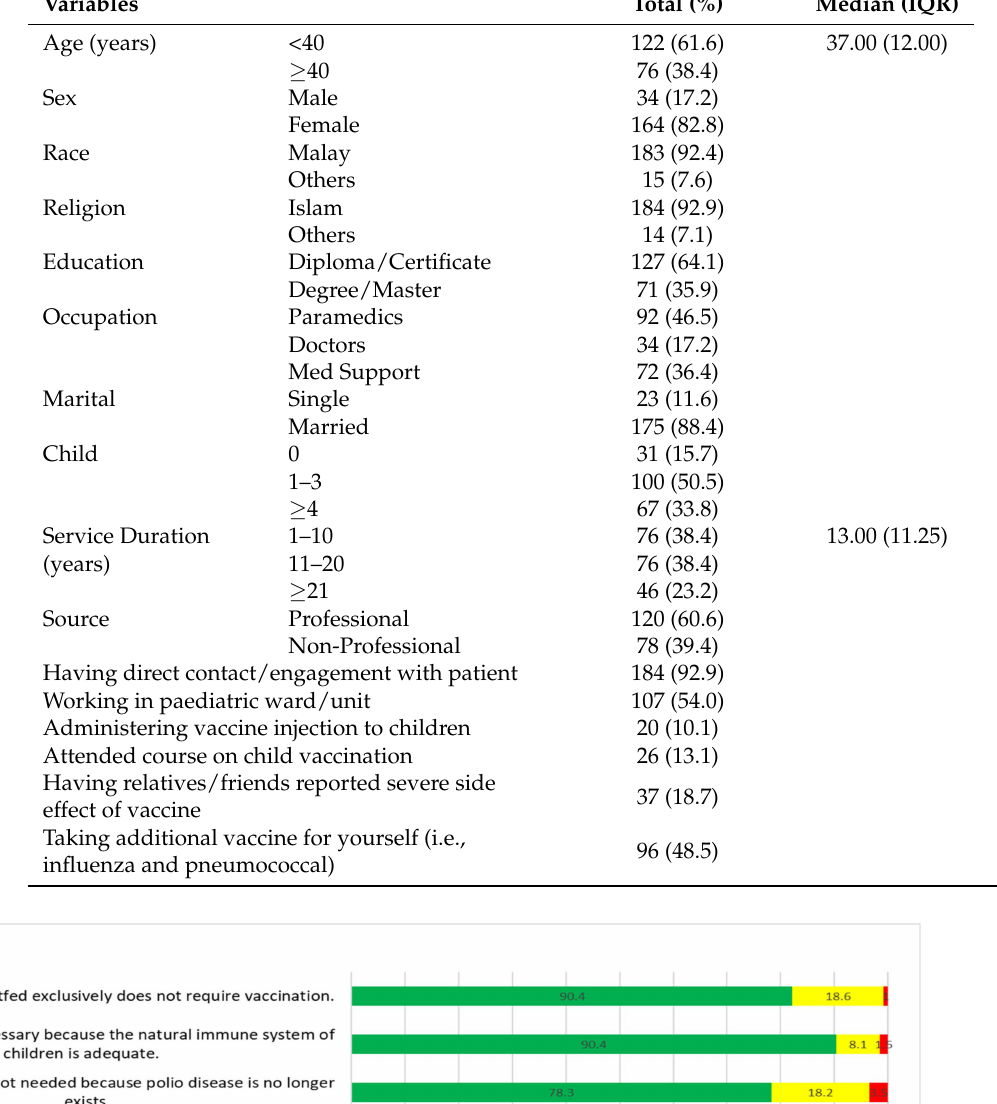
Table 1. Demographic information, main source of information, and personal experience of partici- pants (n = 198).